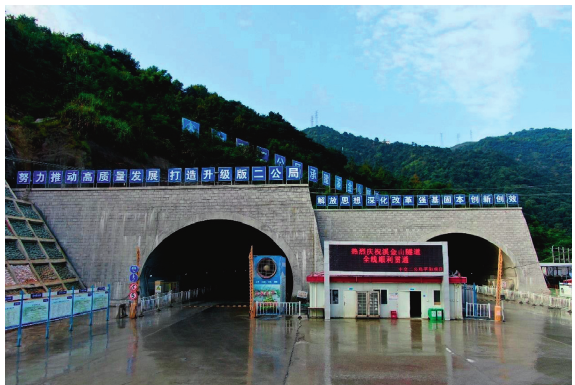
Figure 5: Ventilation and disinfection in Case 3 (source: http:// www.zgjtb.com/zhitong/2020-10/26/content_251119.htm).